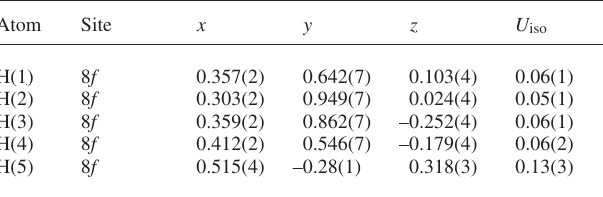
Table 2. Atomic coordinates and displacement parameters (in Å 2 )